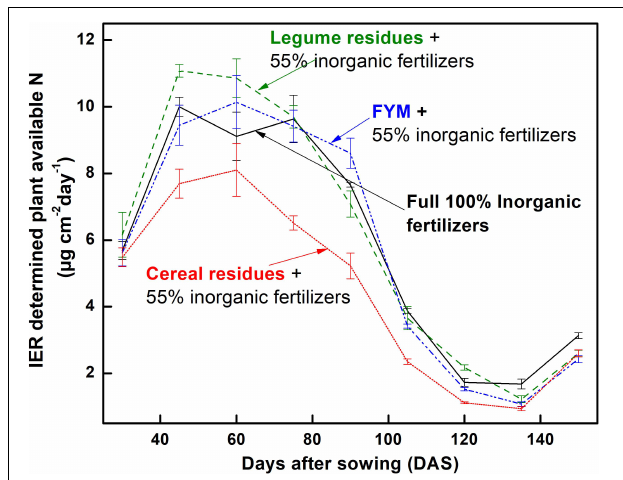
FIGURE 3 | Trends in IER determined plant-available total-N in soil solution during the wheat ( Triticum aestivum ) crop growth under different management. Error bars denote ± 1SD. IER, Ion exchange resin strips. Treatments are described in Figure 2 legend. The curve for crop residues denotes averaged values for WS and RS treatments, and the curve for legumes denotes averaged values for GM and LE treatments.